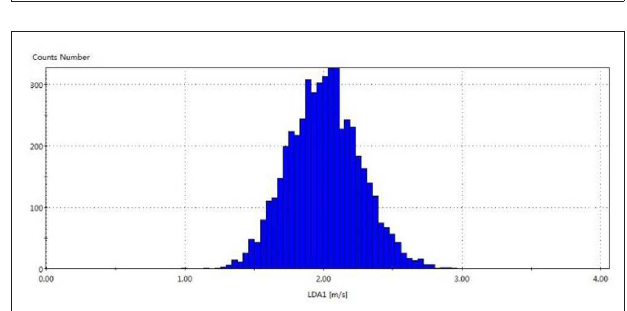
FIGURE 4 | Example of sampled velocity distribution.